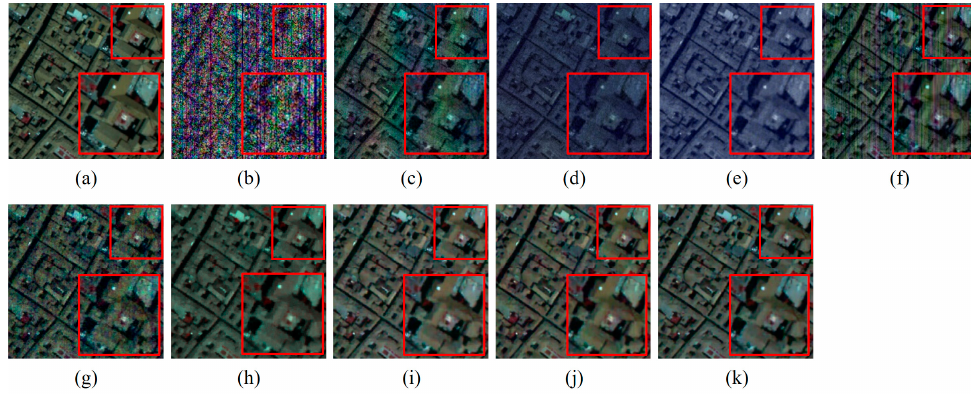
Figure 7. False color images synthesized with band 14, 24 and 54 of the denoised Pavia Center data in mixture noise case. ( a ) Clean; ( b ) noisy; ( c ) LRMR; ( d ) NAILRMA; ( e ) NGmeet; ( f ) L1HyMixDe; ( g ) E3DTV; ( h ) LRTDTV; ( i ) HSI-DeNet; ( j ) HSID-CNN; ( k ) ours.